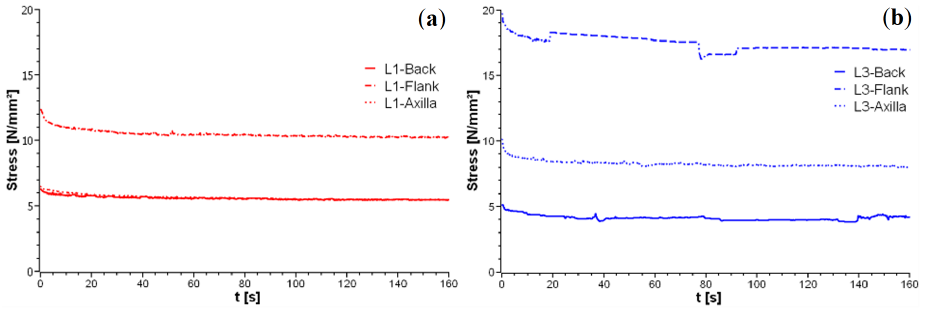
Figure 17. Relaxation curves of fiber-bundles for leather samples: ( a ) L1 and ( b ) L3 with 5%- elongation of initial length.